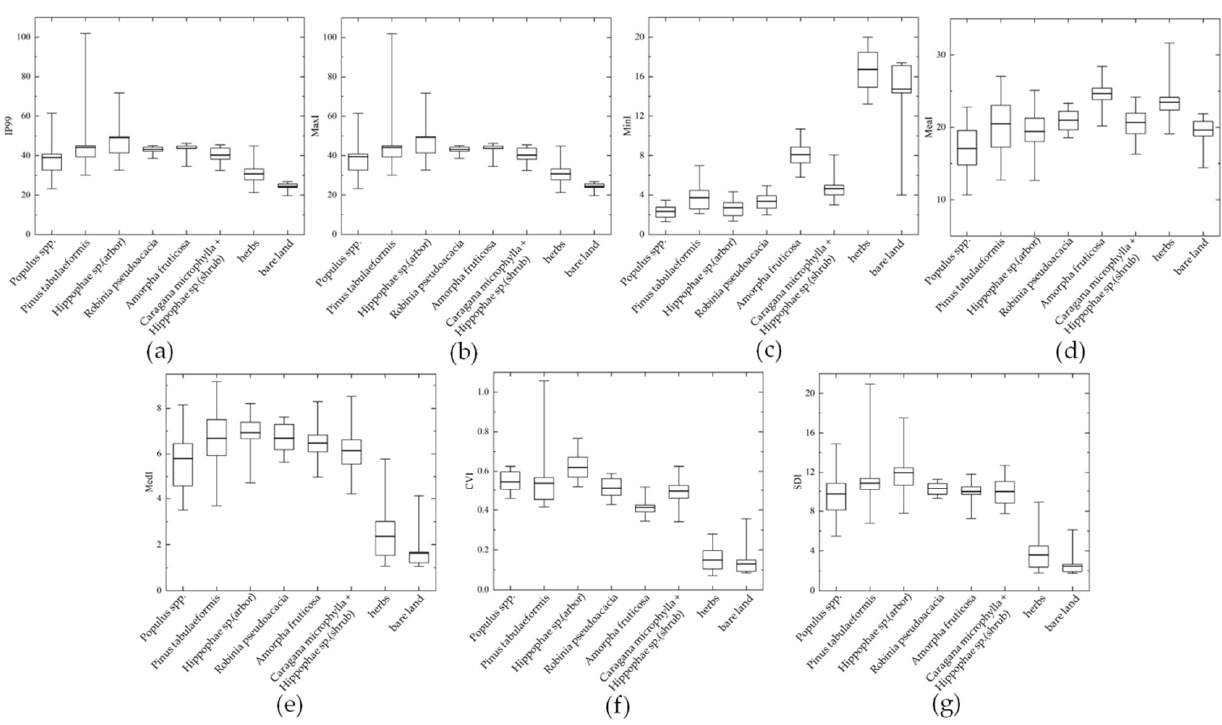
Figure 5. Intensity distribution of eight types of vegetation species composition: ( a ) intensity per- centile of 95% (IP99); ( b ) maximum intensity (MaxI); ( c ) minimum intensity (MinI); ( d ) mean intensity (MeaI); ( e ) median intensity (MedI); ( f ) coefficient of variation of intensity (CVI); ( g ) standard deviation of intensity (SDI).